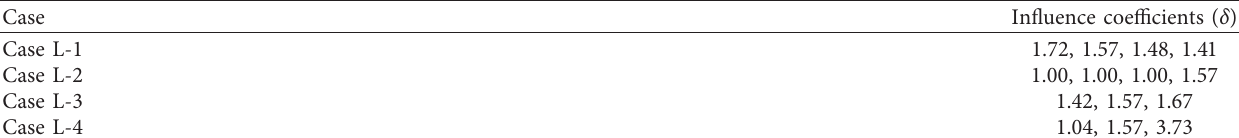
Table 16: Influence coefficients of L-shaped connection in different cases.